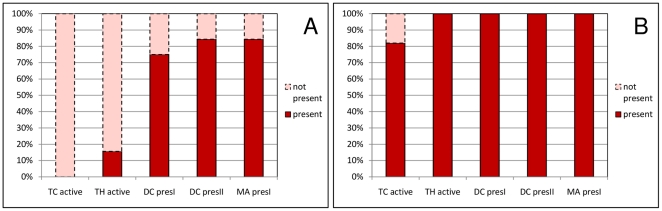
Reasons for Failures in Treatment.The propensity to obtain certain activation states of the immune cell populations is depicted. Experiments are grouped into frequent failures (A) that induce a sufficient immune response in less than 50% of the simulations and rare failures (B) with more than 50% sufficient responses. Abbreviations: TC active: active cytotoxic T-cells. TH active: active helper T-cells. DC presI/DC presII: dendritic cells presenting peptides on MHC I/MHC II. MA presII: macrophages presenting peptides on MHC II.